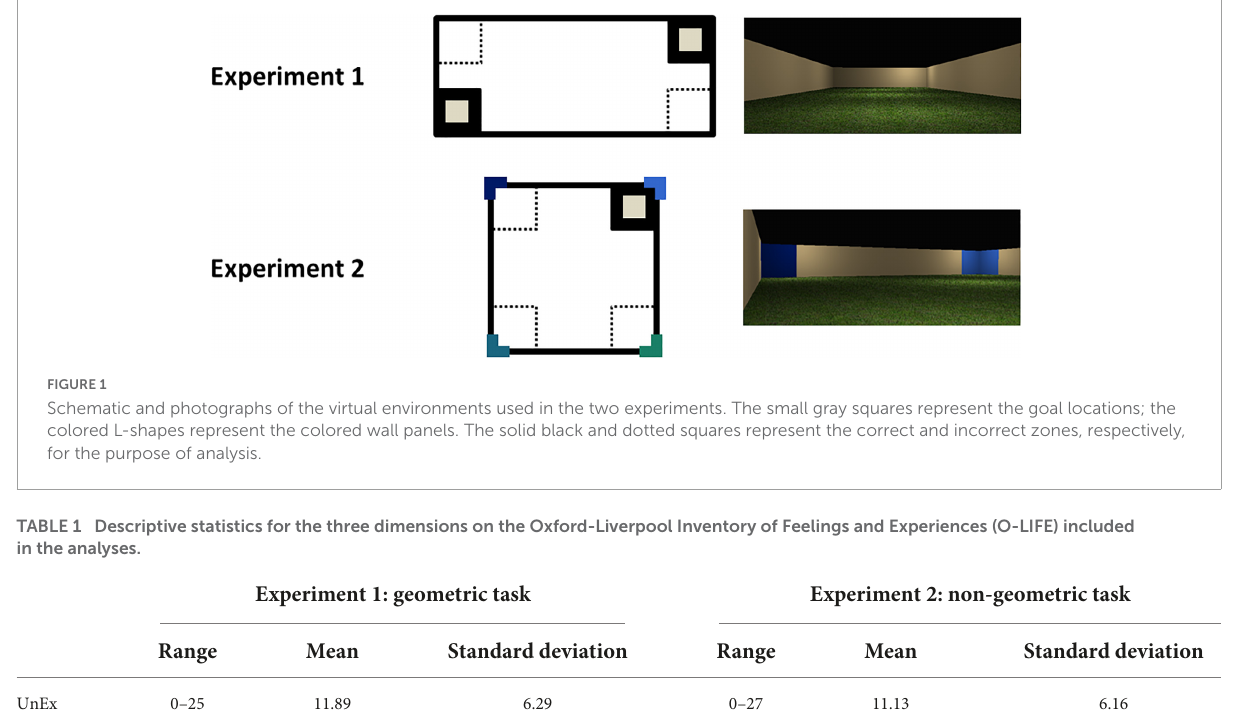
Range Mean Standard deviation 11.89